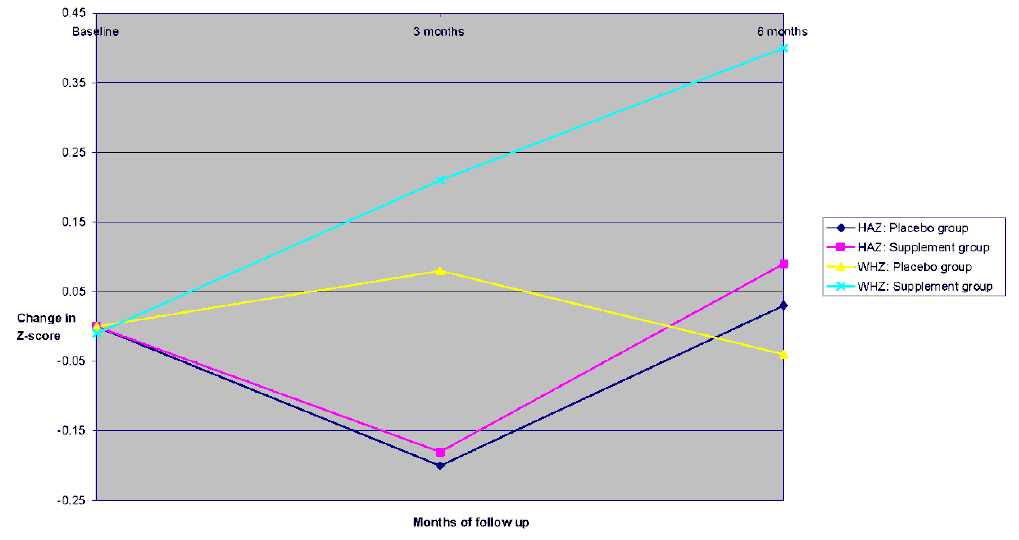
Figure 2. Change in anthropometrics Z -scores over the six month follow-up period among children who completed the study.